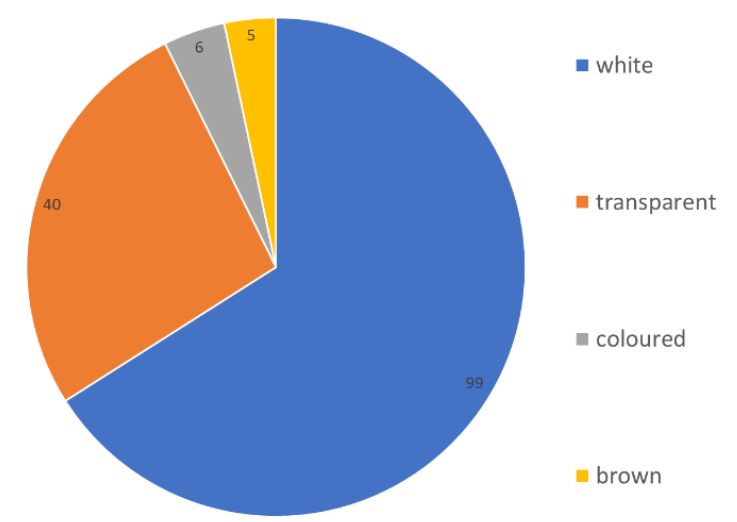
Figure 9. Colour of the plastic body of the packaging; numbers: number of samples, n = 150 .